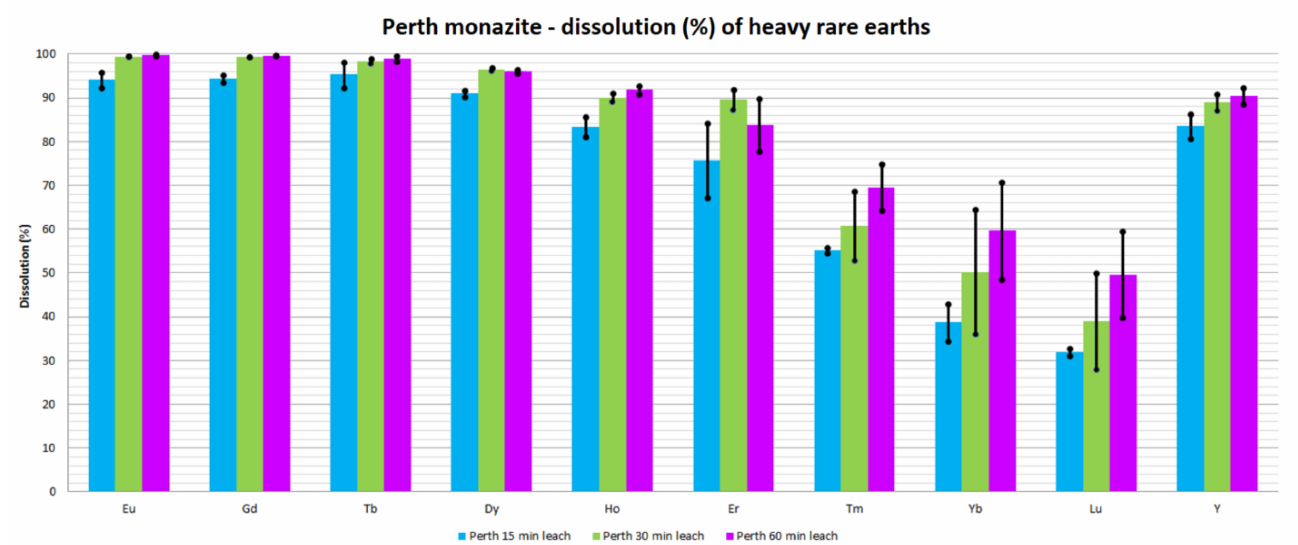
Figure 2. Light rare earth dissolution in leach: Perth monazite (260 ◦ C leach, 215 g/L concentrate).